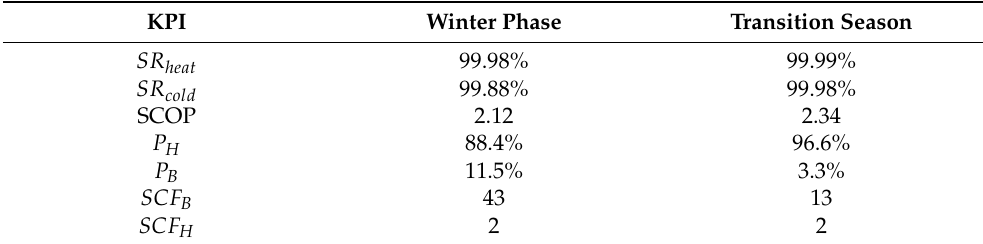
Table 2. The KPIs of the energy system controlled by the developed mode-based control algorithm.